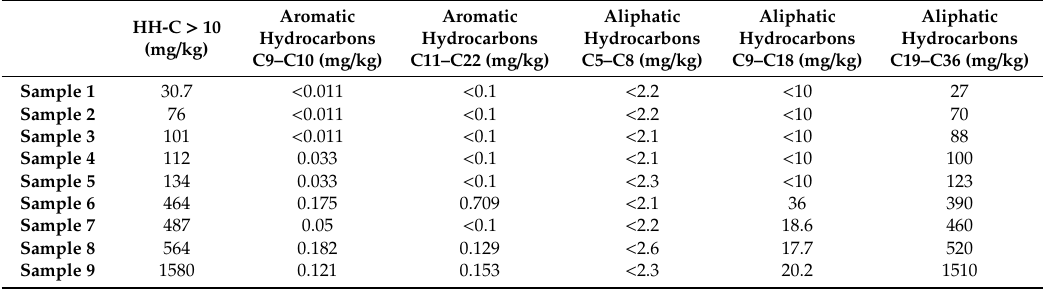
Table 6. Hydrocarbon speciation according to the MADEP approach on nine randomly selected soil